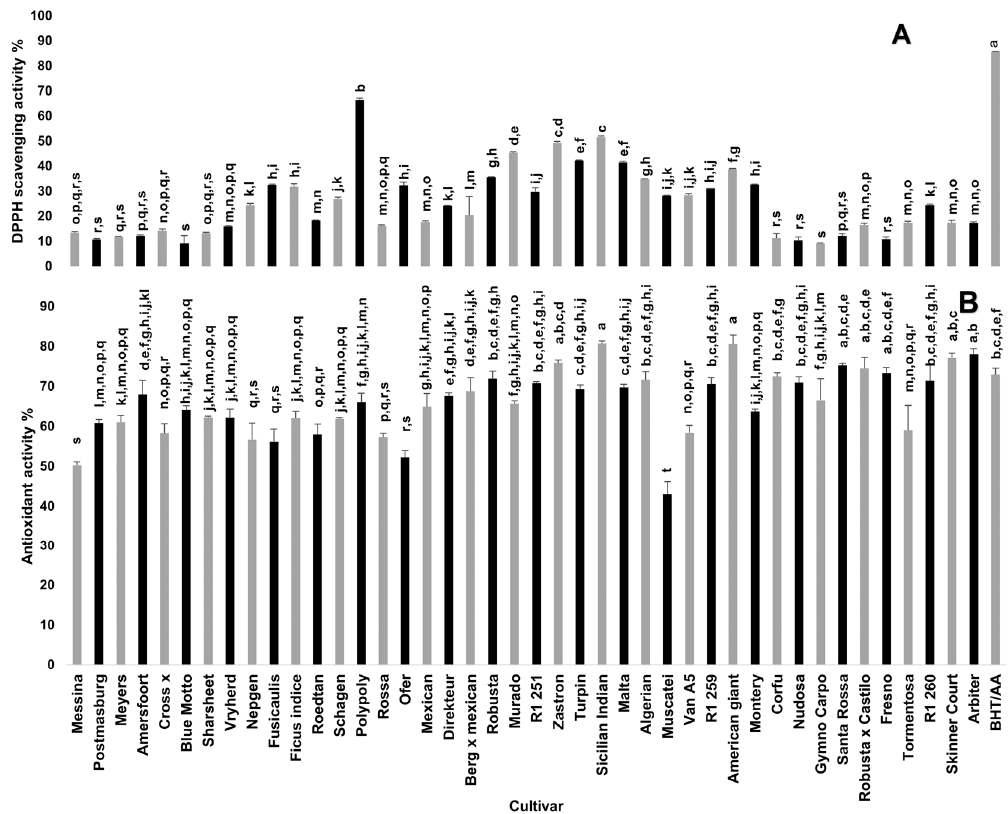
Figure 2. Antioxidant activity of cladode methanolic extracts from 42 spineless cactus pear cultivars. ( A ) DPPH free radical scavenging activity (%) at 10 mg/mL extract concentration. ( B ) Antioxidant activity (%) based on bleaching rate in β -carotene-linoleic acid assay. Bars bearing different letters in each graph indicate significant differences ( p = 0.05) according to Duncan’s Multiple Range Test (DMRT). Values are means ± standard errors (n = 3). Butylated hydroxytoluene (BHT) was used as a standard for total antioxidant activity while ascorbic acid (AA) was used as a standard for DPPH free radical scavenging